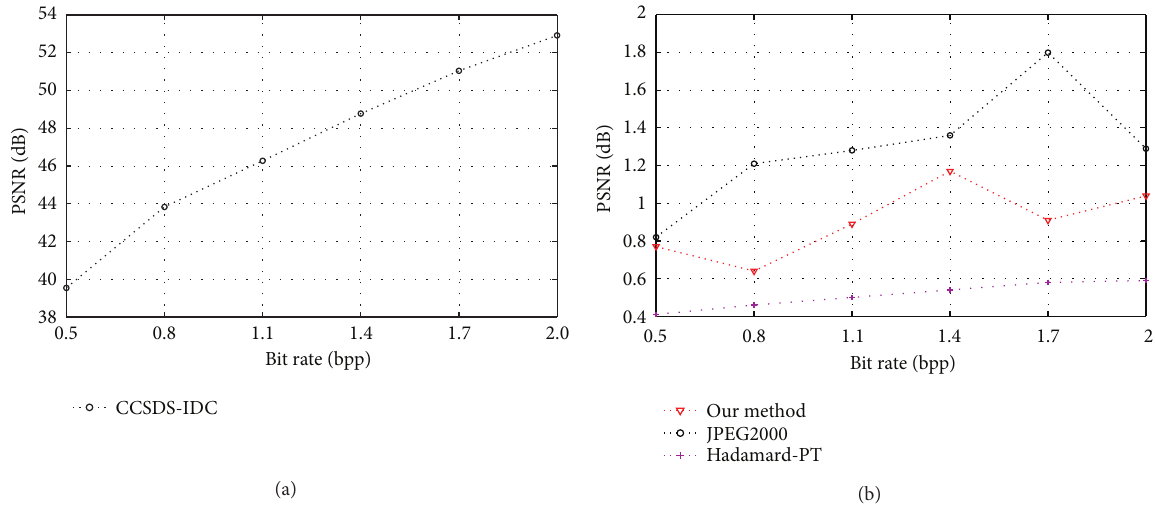
Figure 21: The test and comparison result of multiband images, the left is PSNR of 3 compression codec, and the right is PSNR difference between CCSDS with other 2 compression codecs.